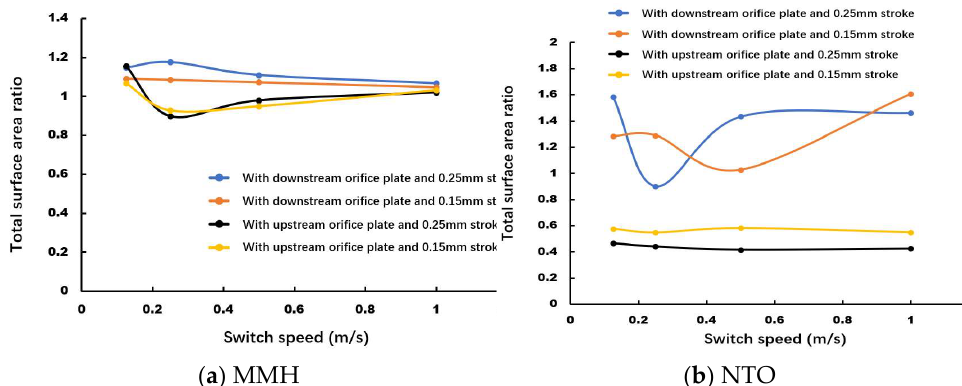
Figure 15. Comparison of MMH ( a ) and NTO ( b ) flowrate fluctuation under different switch speeds, with downstream orifice plate and 0.15 mm stroke.